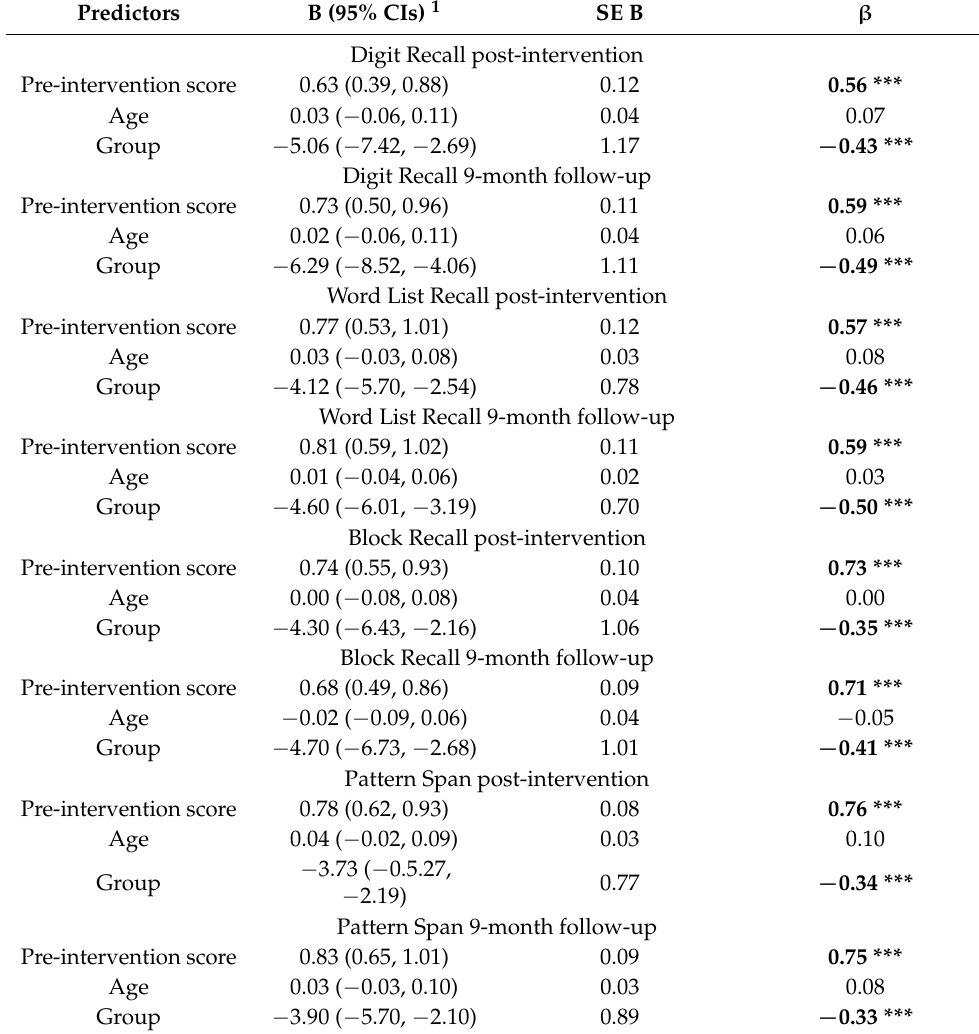
Table 5. Summary of step 2 of the regressions for the short-term memory near-transfer outcome variables (Digit Recall, Word List Recall, Block Recall and Pattern Span). Predictors B (95% CIs) 1 SE B β Digit Recall